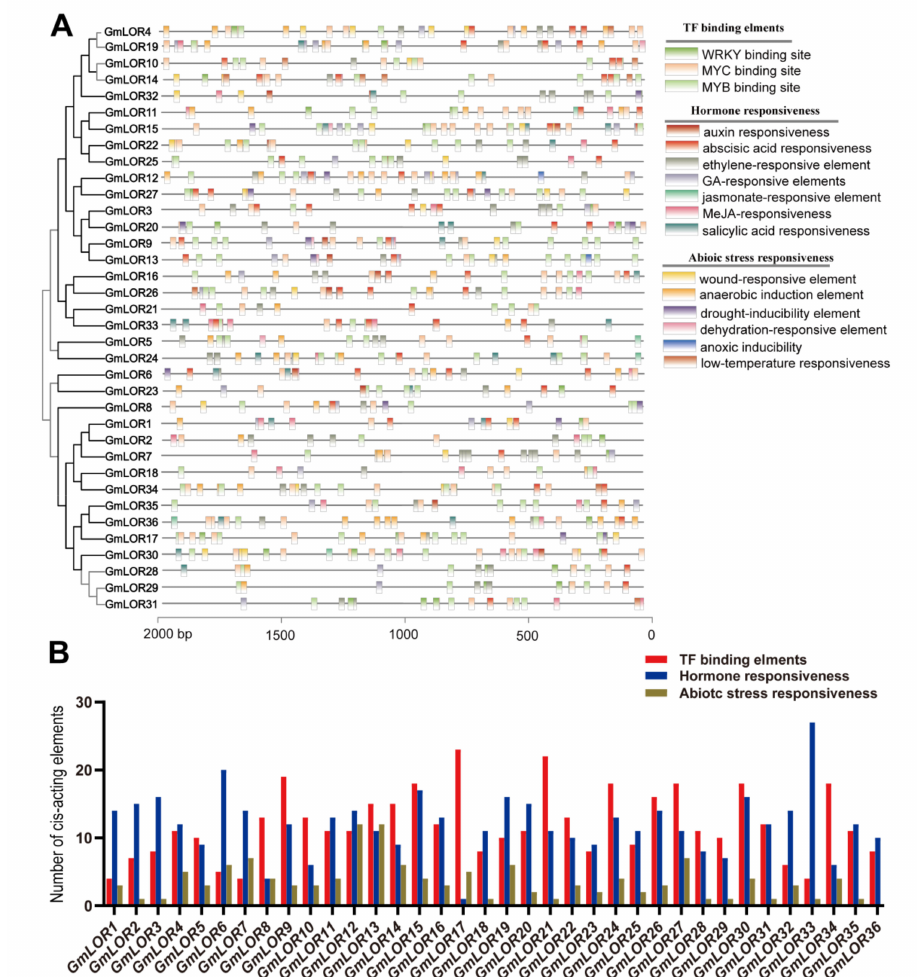
Figure 5. The analysis of the cis-elements in the promoter regions of GmLOR genes. ( A ) Predicted cis-elements in the 2000 bp upstream regions of GmLOR genes and three main categories of cis-elements. The names of the cis-elements are indicated by different-colored boxes. The scale indicates the relative position of each cis-element relative to the start codon, ATG. ( B ) Three categories of cis-elements presented in the promoter regions of GmLOR